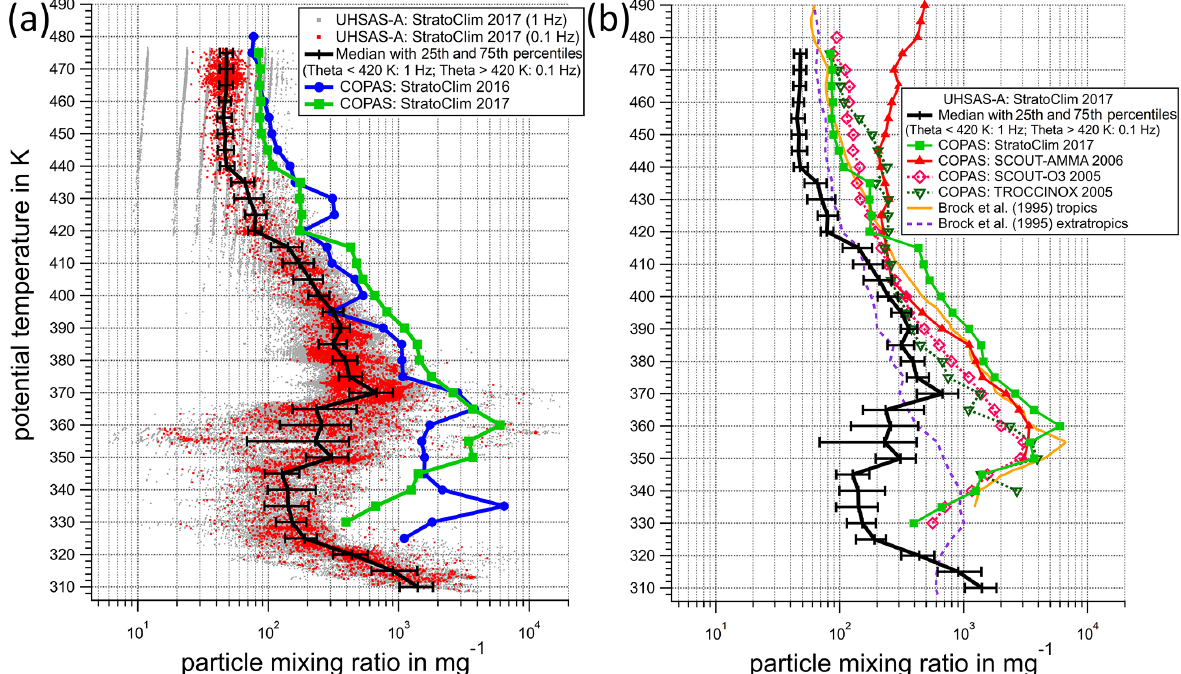
Figure 3. Vertical profile of the particle mixing ratio with the potential temperature as the vertical coordinate. Panel (a) shows the 1Hz resolved particle mixing ratios measured with the UHSAS-A (diameter range of 65nm–1µm) during StratoClim 2017 as gray dots and the 0.1Hz averaged particle mixing ratios as red dots. The median profile of all flights is plotted in black in steps of 5K (each over a ± 2 . 5K interval) with the 25th and 75th percentiles, based on the 1Hz data for (cid:50) < 420K and on the 0.1Hz data for (cid:50) > 420K. The median profile of the particle mixing ratio measured by the COPAS (diameter range of 10nm–1µm) during the StratoClim 2016 measurement campaign in the extratropics (Kalamata, Greece) is shown in blue, and the profile measured during StratoClim 2017 (Kathmandu, Nepal) in the tropics is shown in green. Panel (b) includes the median profile (with the 25th and 75th percentiles) of particle mixing ratios measured with the UHSAS-A during StratoClim 2017 (black line); the median profiles measured by COPAS for particle diameters larger than 10nm during StratoClim 2017 (Nepal, green line), SCOUT-AMMA 2006 (West Africa, red line), and SCOUT-O3 2005 (Australia, red dotted line); and for particle diameters larger than 6nm during TROCCINOX 2005 (Brazil, green dotted line), as depicted in Borrmann et al. (2010). The median profiles, digitized from Fig. 1 in Brock et al. (1995), for the tropics are plotted as an orange line, and those for the extratropics are plotted as a dashed purple